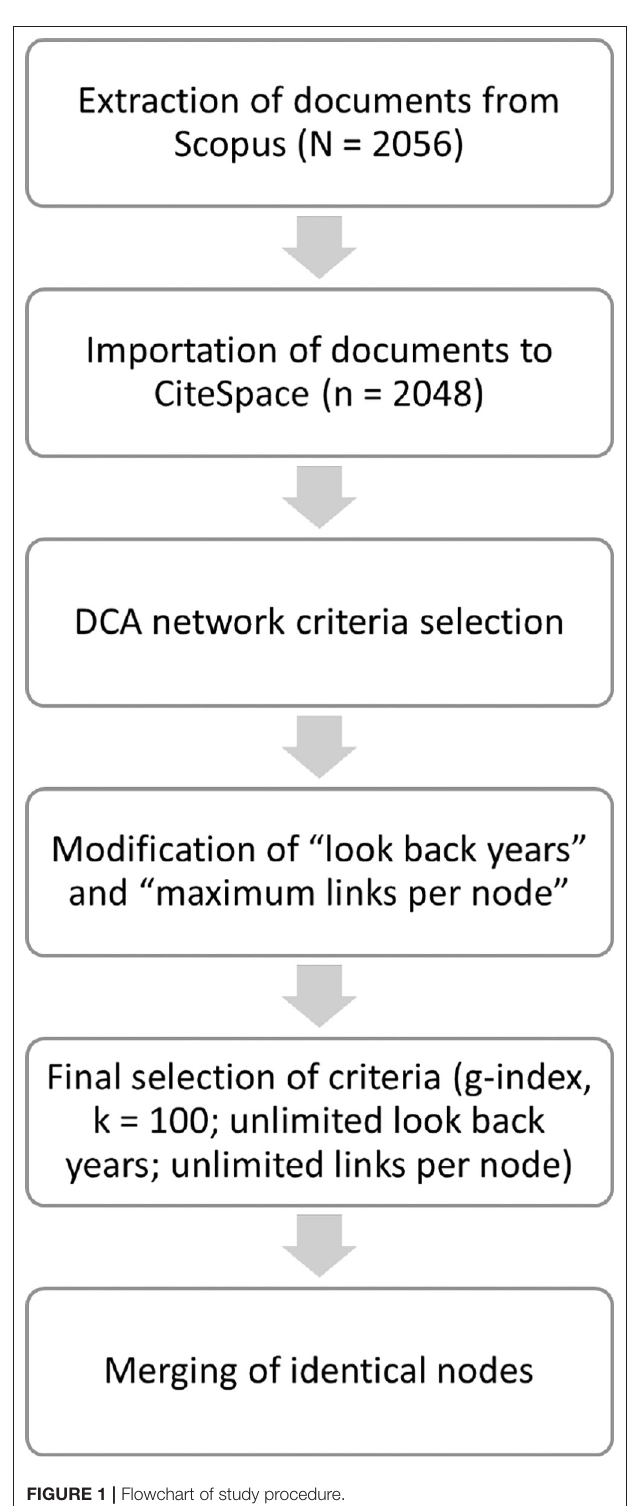
FIGURE 1 | Flowchart of study procedure.